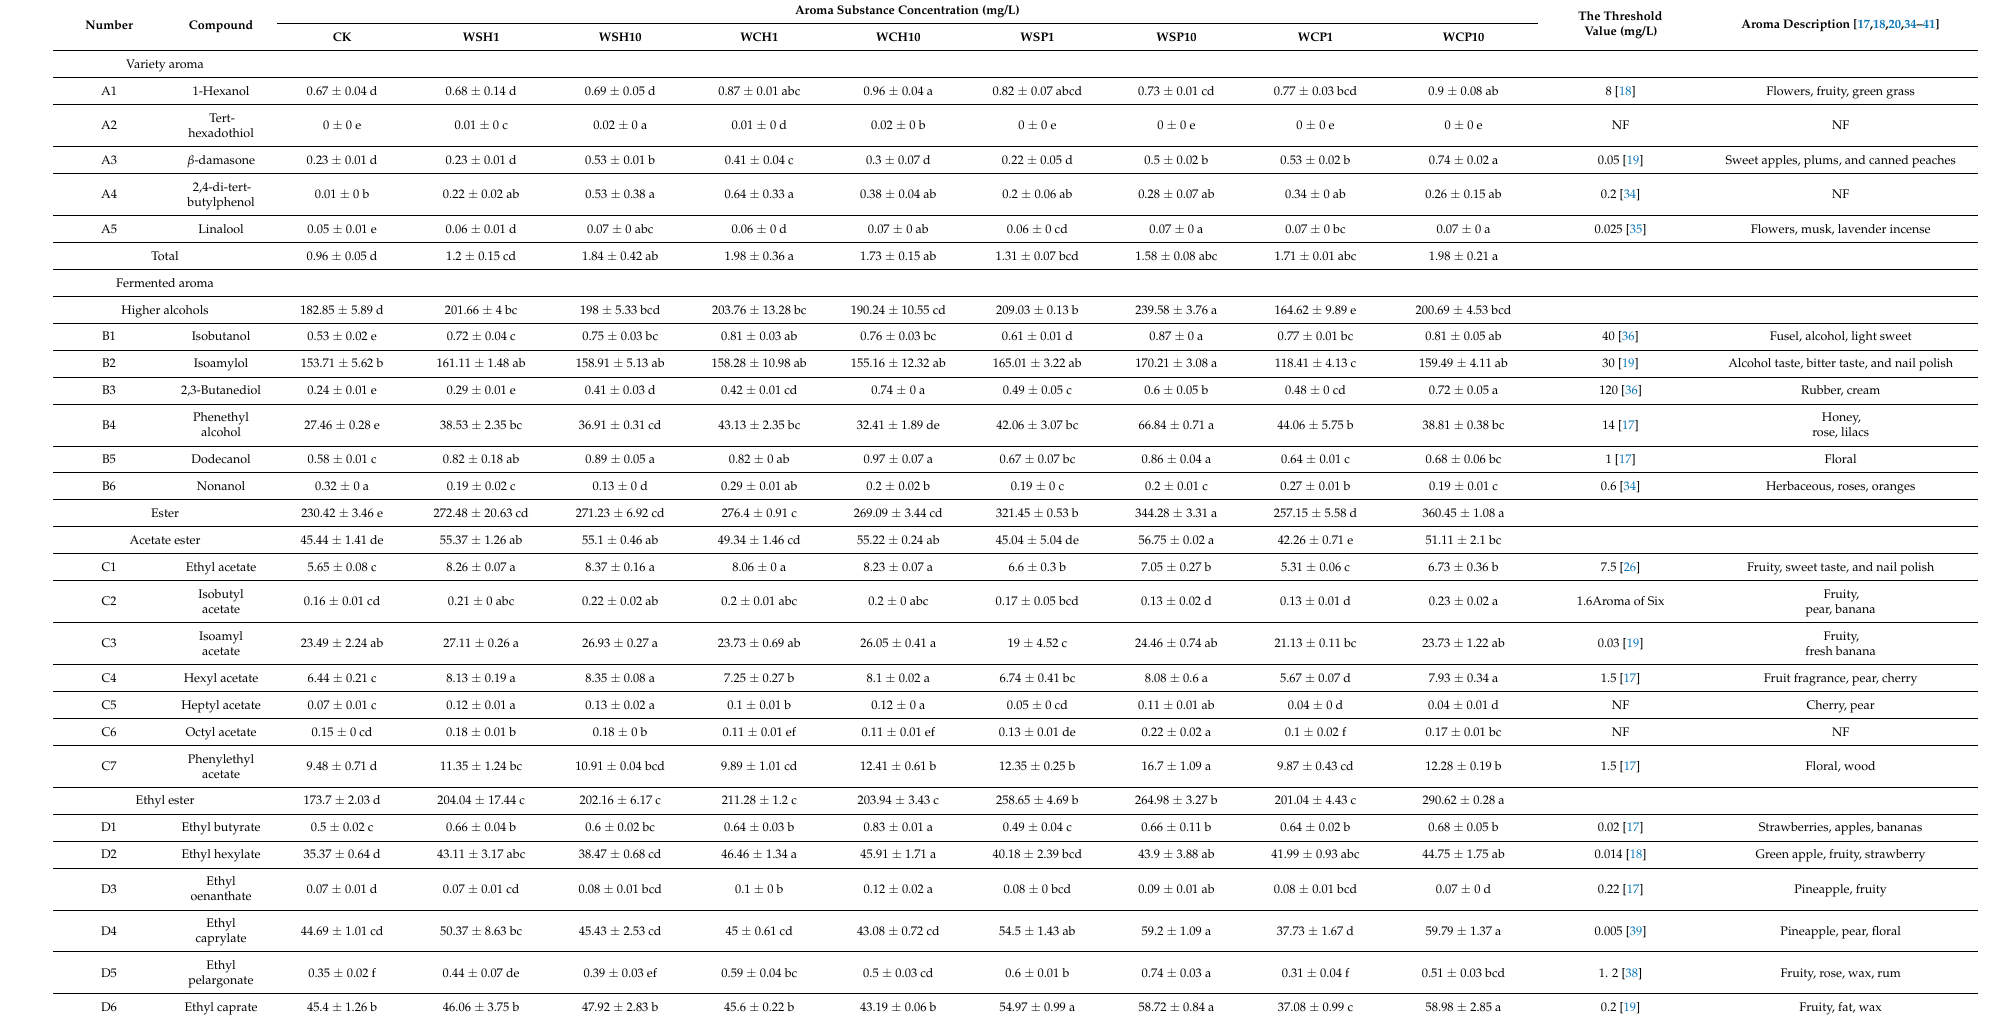
Table 5. Volatile compounds of the wines obtained by different fermentation